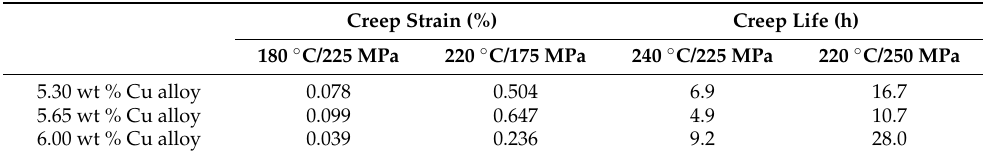
Table 2. Creep properties of three Al–Cu–Mg–Ag alloys under different creep conditions indicated in Figure 1.